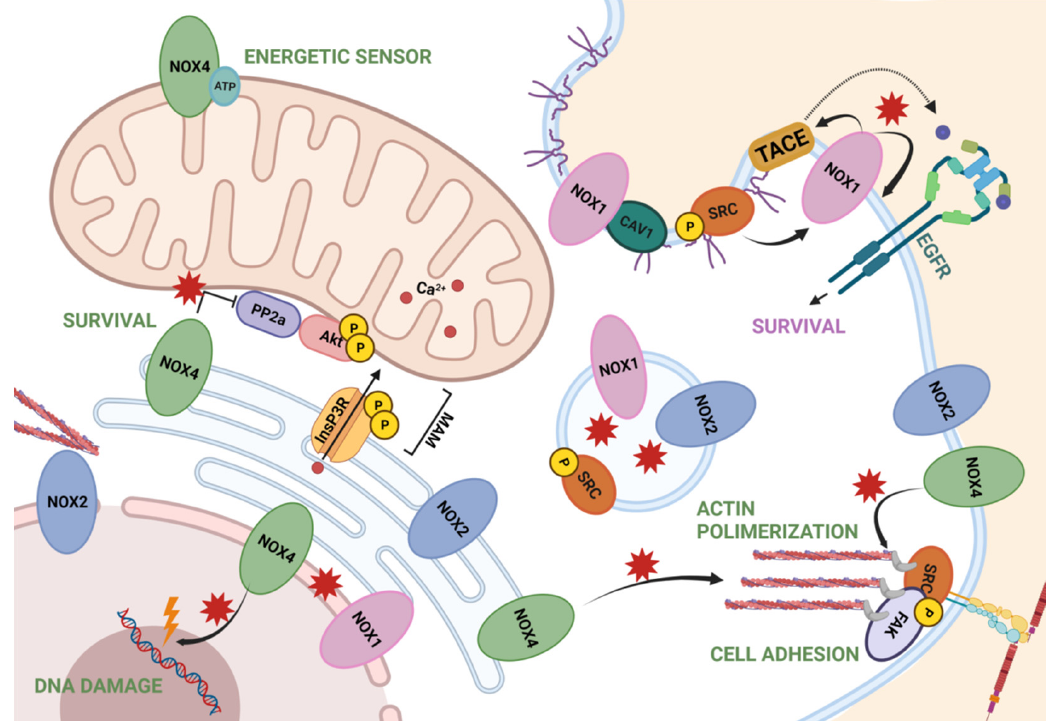
Figure 2. Summary of NOXs localization and NOX-dependent redox signaling through ROS. NOX1 is involved in survival pathways by EGFR and found in endosomes and nuclear membrane. NOX2 is found in the endoplasmic reticulum, endosomes and nuclear membrane, associated with the cytoskeleton. NOX2 is also associated, along with NOX4, to the plasma membrane and near the focal adhesions, regulating cell adhesion. Finally, NOX4 also mediates actin polymerization from the ER, as well as survival signaling when located in MAMs. In the mitochondria, it acts as an energetic sensor, and in the nuclei, is known to produce ROS in the perinuclear and nuclear space. Figure was created with BioRender.com (accessed on 12 July 2021).